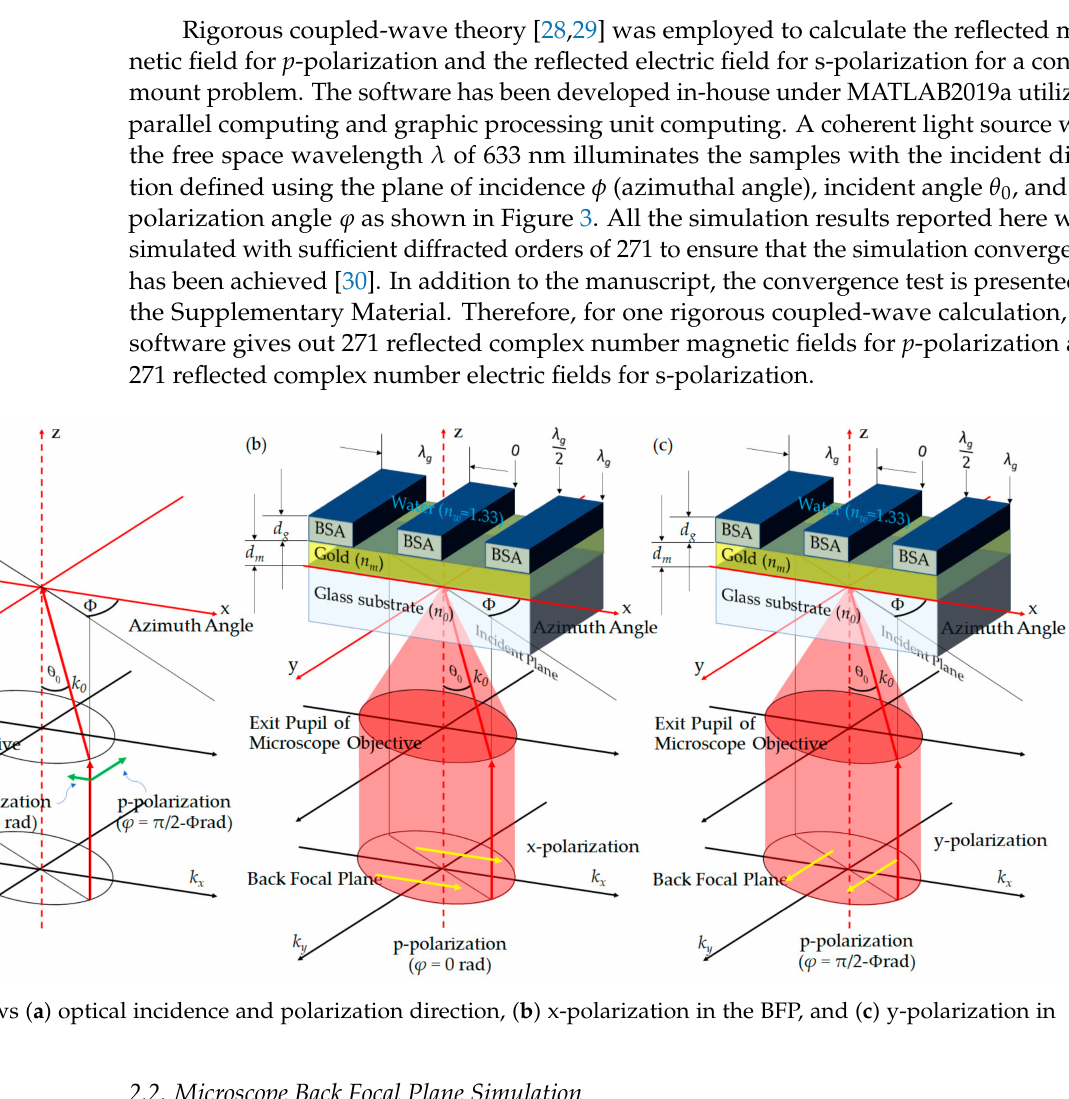
Figure 2. Schematic diagram of simulated structures, ( a ) bare gold sample in water backing environment, ( b ) uniform BSA protein-coated sample, and ( c ) 50 to 50% fill-factor grating sample.